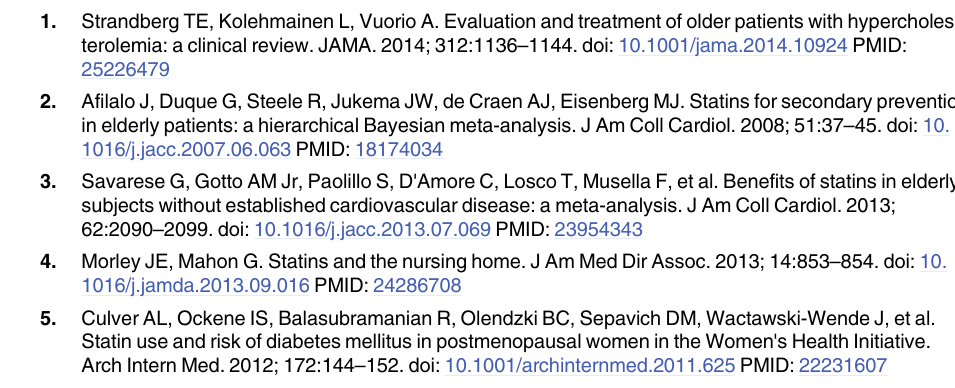
S2 Table. Overall and subgroup analyses for community-dwelling older patients with dia- betes mellitus statin users vs. non-users (propensity score 1:1 matching models). MPI-S- VaMA: Multidimensional Prognostic Index- Standardized Multidimensional Assessment Schedule for Adults and Aged Persons Patients were matched, using a 5 to 1 greedy 1:1 PS matching algorithm for: age at SVaMA evaluation, sex, Nursing Care Needs (VIP), cognitive status (VCOG), pressure sores risk (VPIA), activities of daily living (VADL), mobility (VMOB), social support (VSOC) (all MPI-SVaMA domains), the needing of care assistants, the main diagnoses of fractures, cancer, dementia, stroke, hypokinetic syndrome and cardio- vascular, respiratory neurological or other diseases and number of all medications prescribed within one year before patient ’ s enrollment (tertiles). (cid:3) Testing whether the effect of statins on mortality risk was differential within MPI-SVaMA grades (effect